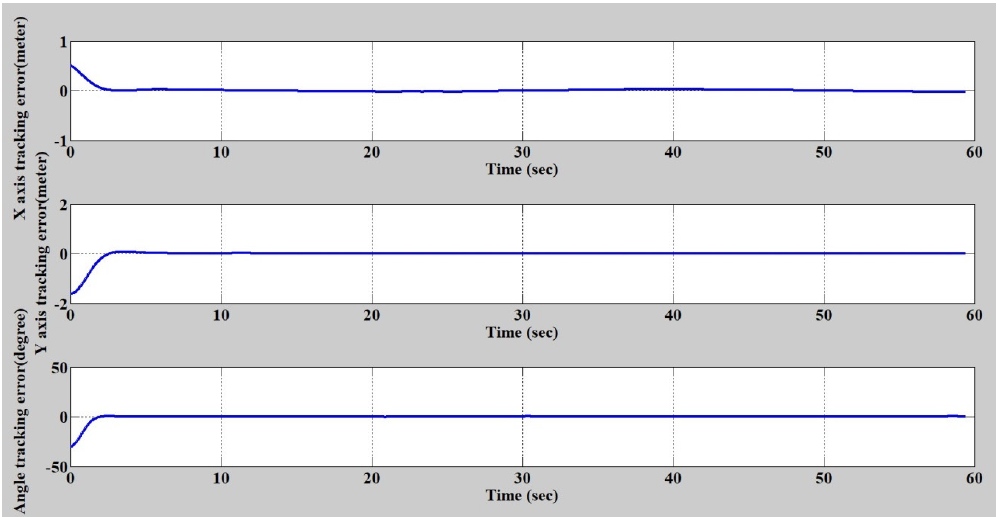
Figure 12. Results of S-type trajectory tracking errors concerning initial point ( x c = 1.9 m, y c = 0 m).